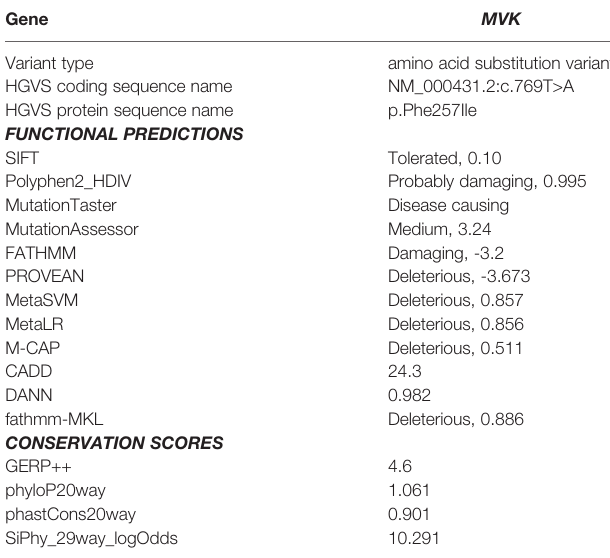
TABLE 1 | Results of in silico analysis for the candidate mutation in the patient. Gene MVK Variant